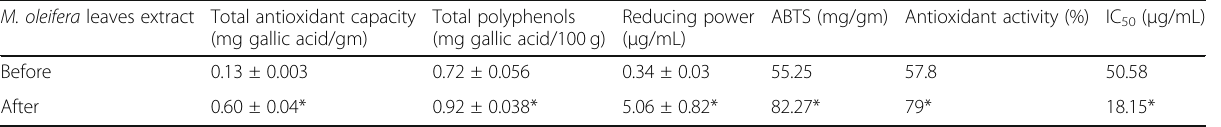
Table 2 Total antioxidant capacity and free radical scavenging activity in M. oleifera leaves extracts before and after incorporating of